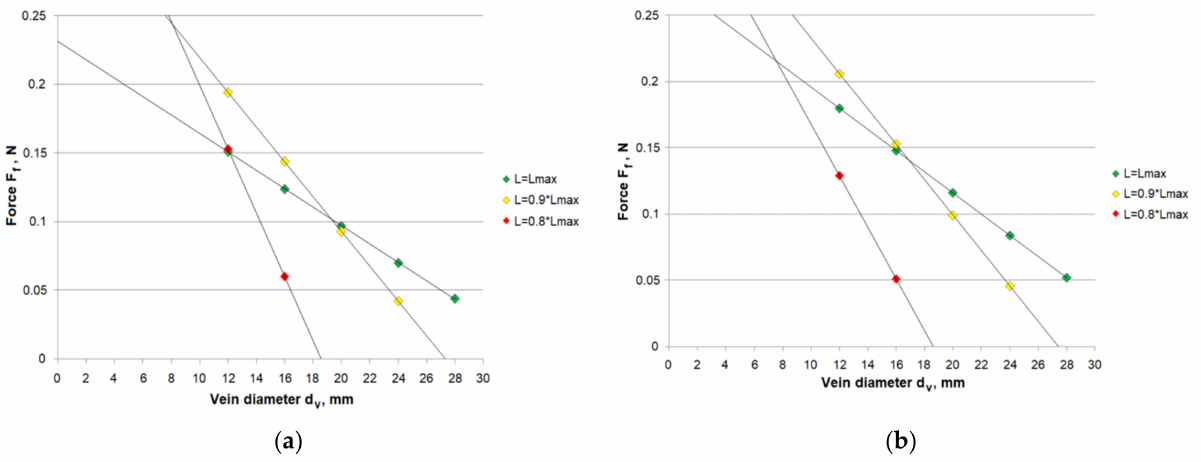
Figure 9. The aggregated F f (d v ) dependence charts created with the use of: ( a ) the results of force measurements for all cutting elements; ( b ) the results of force measurements for a single cutting